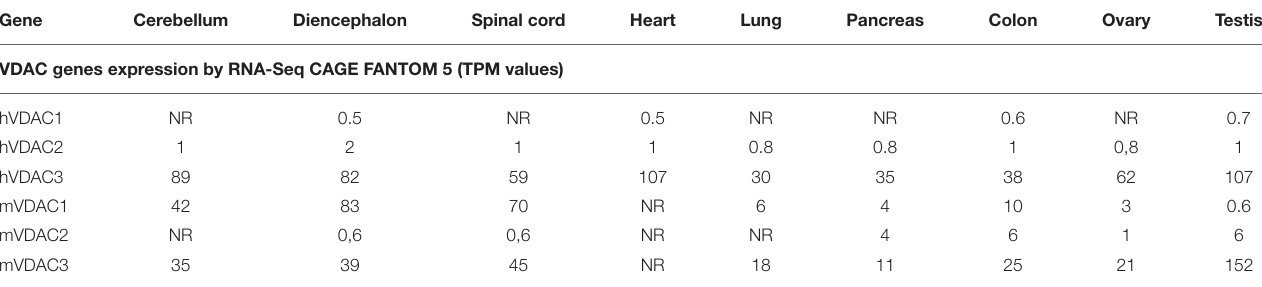
TABLE 1 | Human and mouse VDAC expression in different tissues by RNA-Seq CAGE FANTOM 5 project (TPM values). Gene Cerebellum Diencephalon Spinal cord Heart Lung Pancreas Colon Ovary Testis VDAC genes expression by RNA-Seq CAGE FANTOM 5 (TPM values) hVDAC1 NR 0.5 NR 0.5 NR NR 0.6 NR 0.7 hVDAC2 2 hVDAC3 89 82 mVDAC1 42 83 70 NR NR 0,6